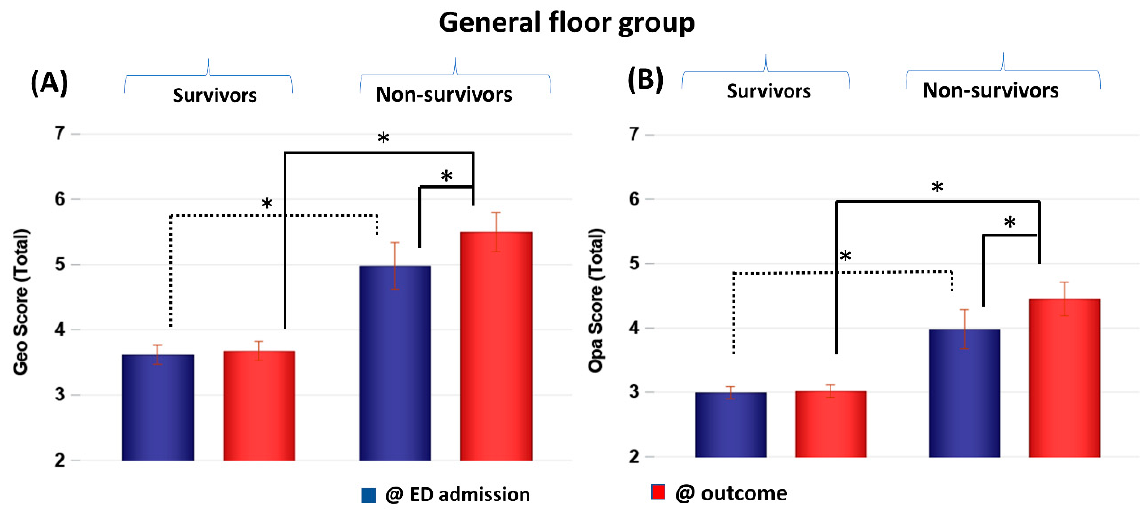
positive patients were scored (range: 0–8) based on the extent and degree of opacities (see Methods). Figure 1. Examples of CXRs with different geographic extent and opacity scores. CXRs of COVID-